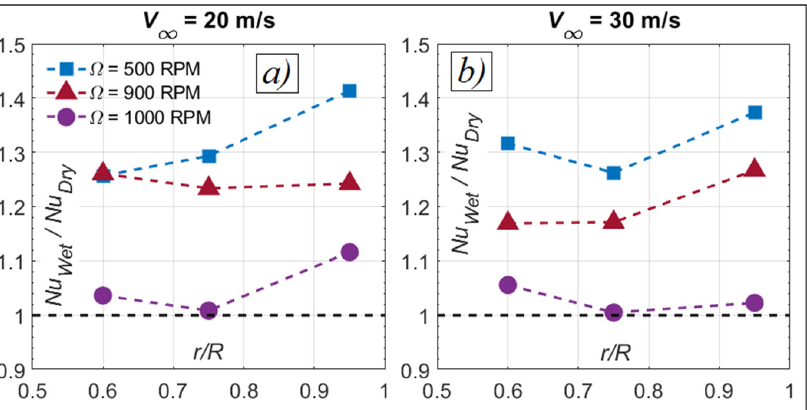
Figure 12. Ratios of the Calculated Nu Wet to Nu Dry for the Anti-Icing Tests at ( a ) V ∝ = 20 m/s and ( b ) V ∝ = 30 m/s. ( b ) V ∝ = 30